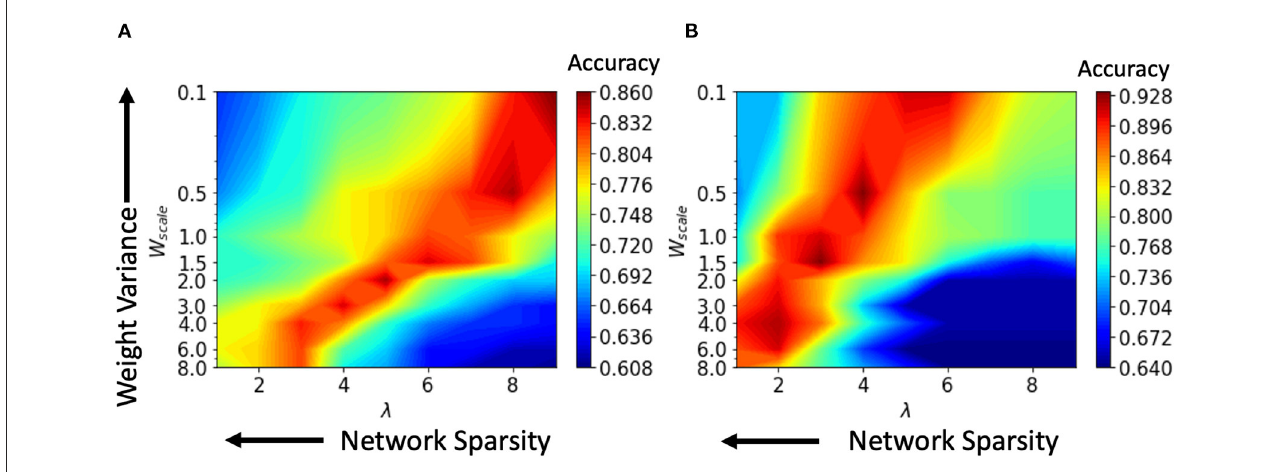
FIGURE6 The variation in performance of the action recognition classification task with network sparsity and weight variance for (A) HoNHoS and (B) HeNHeS. The plot is obtained by interpolating 81 points, and each point is calculated by averaging the results from 5 randomly initialized HRSNNs.